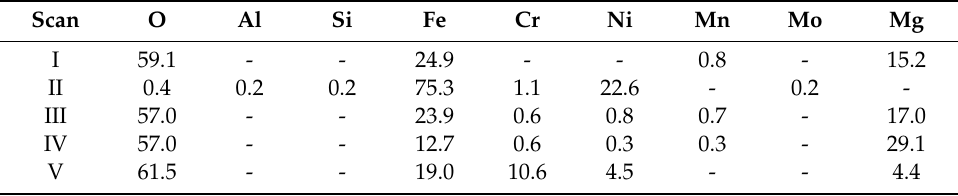
Table 12. Results of EDS scans corresponding with areas indicated by arrows in Figure 14 (in at